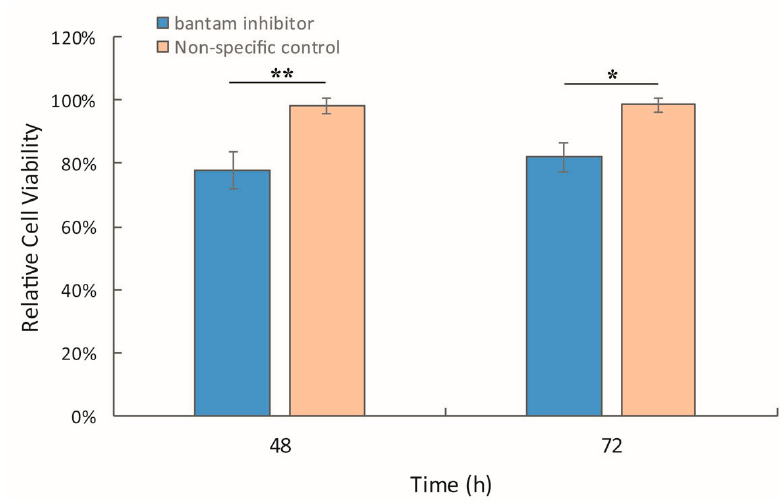
Figure 2. The effect of bantam inhibitor on Sf9 cells. Sf9 cells were transfected with bantam inhibitor (200 nM), and cell viability was determined 48 h and 72 h post treatment. The cell viability in blank control was set as 100%. The means of three replicates was shown, with the error bars indicating the standard deviation. The significance of difference between bantam inhibitor and non-specific treatment was also shown (*: p < 0.05; **: p < 0.01).